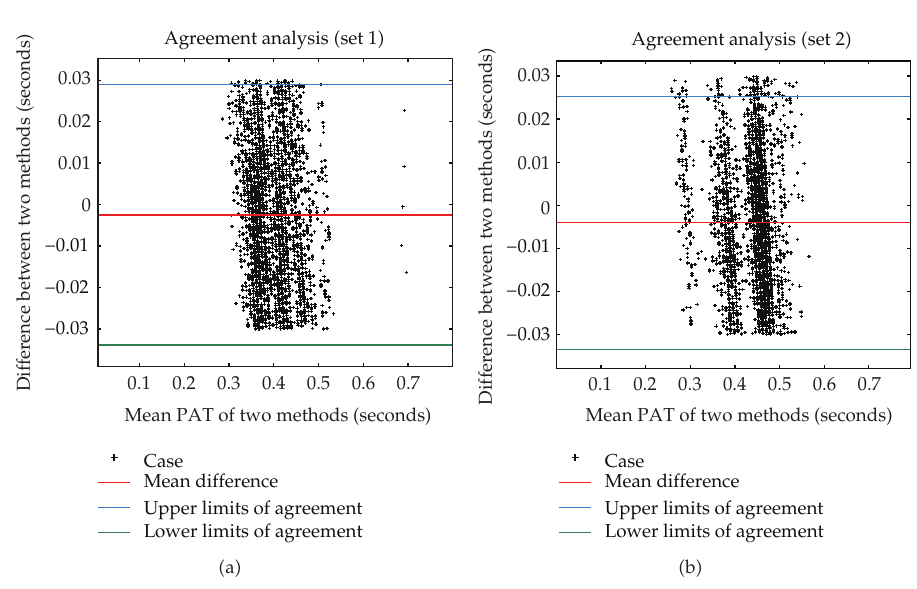
Figure 3: Agreement analysis between the two di ff erent PAT